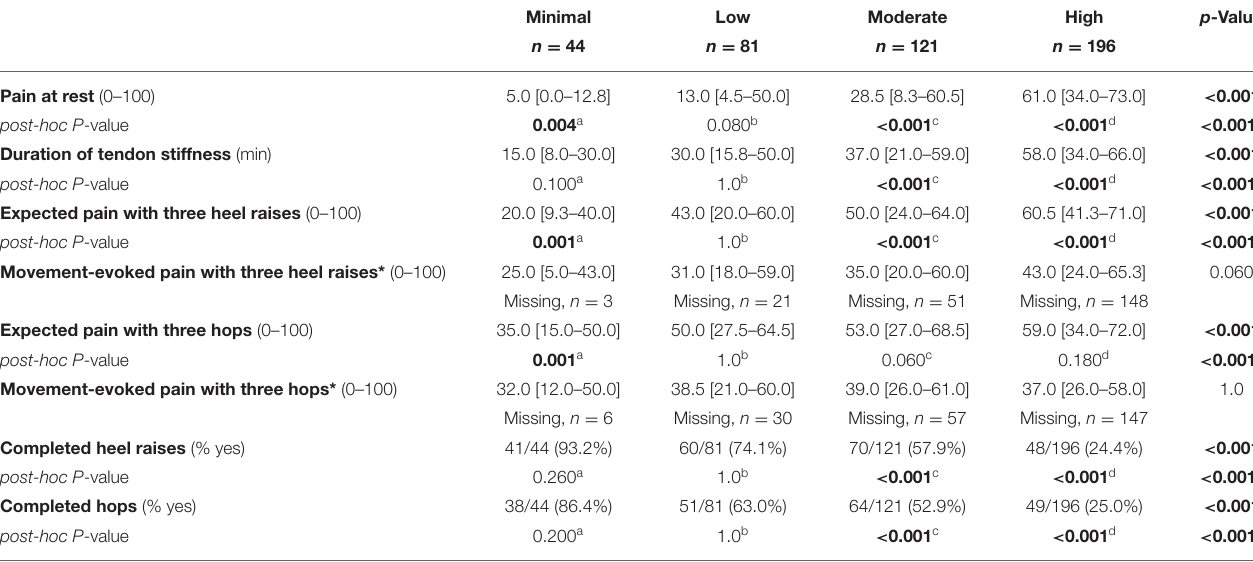
TABLE 2 | Achilles tendon pain (VAS, 0–100) and willingness to complete tendon-loading activities compared between groups stratified by levels of kinesiophobia on the TSK-11 score as Minimal (TSK ≤ 22), Low (TSK 23–28), Moderate (TSK 29–35), and High (TSK ≥ 36). Minimal Low